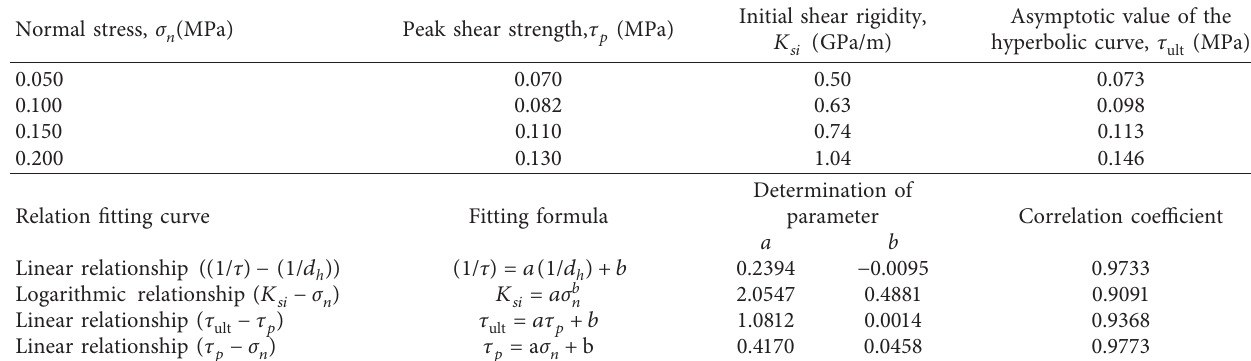
Relation fitting curve Fitting formula